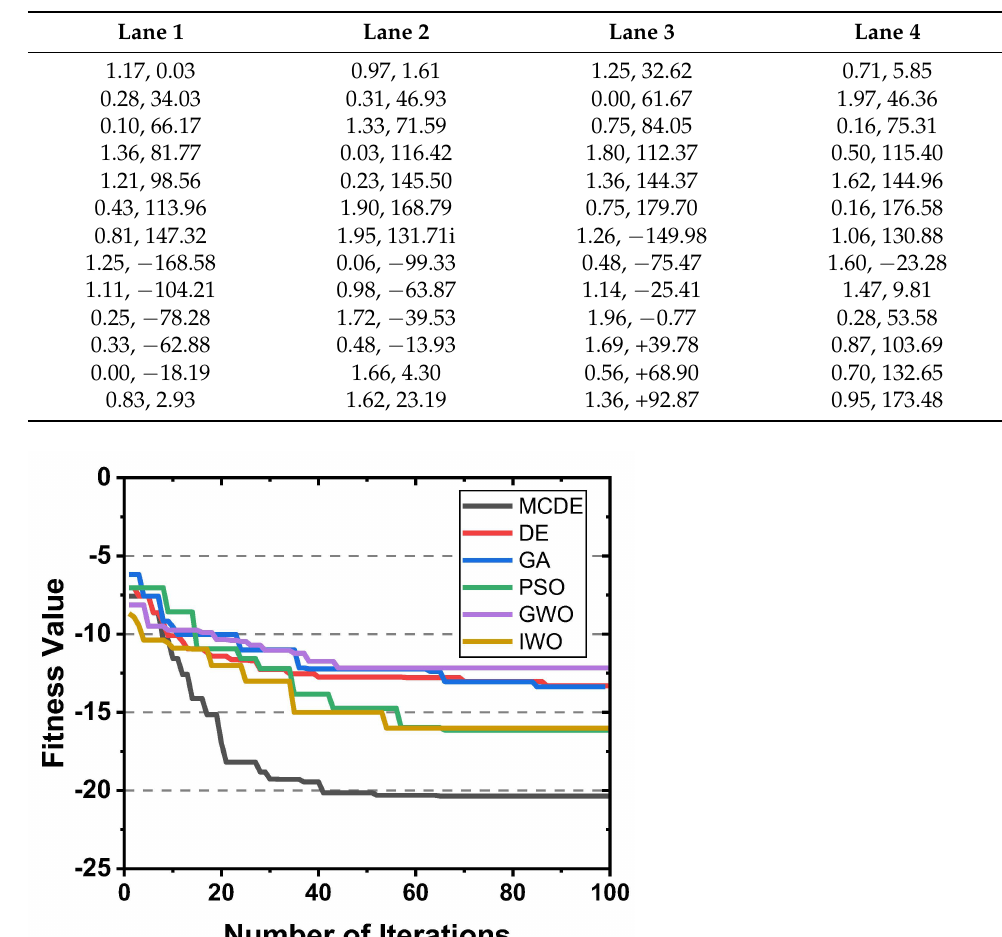
Table 3. The Optimal Placement of the Example Array (Unit: mm).